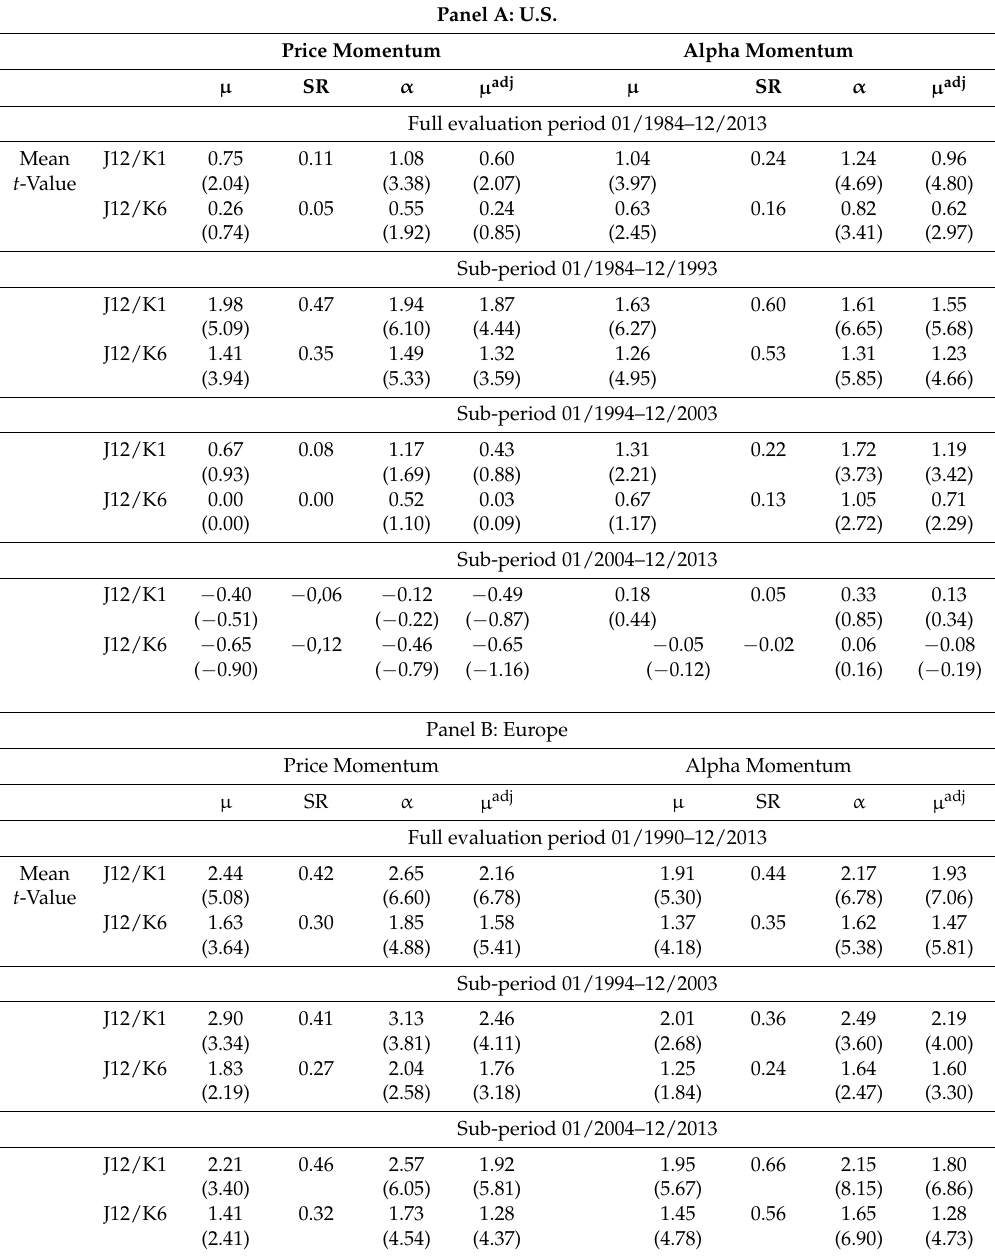
Table 2. Monthly performance of different momentum strategies. Panel A: